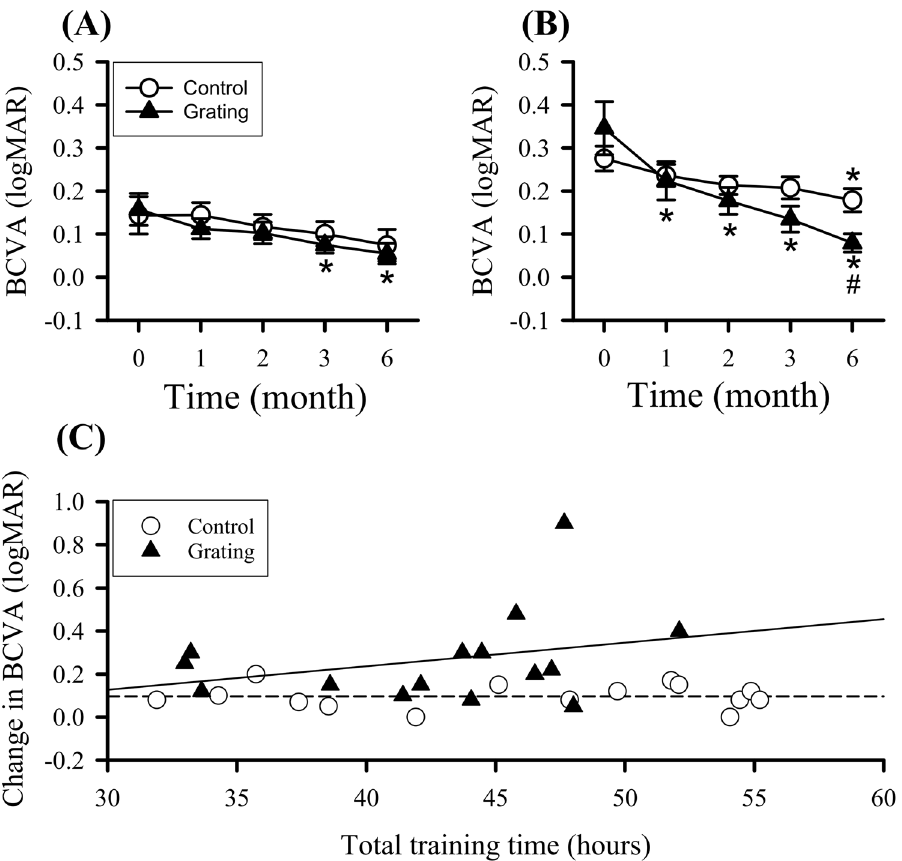
Figure 2. Best-corrected visual acuity (BCVA) at the baseline (0), 1st, 2nd, 3rd, and 6th months after the training. ( A ) BCVAs in patched eyes of the control and Grating groups. ( B ) BCVAs in trained eyes of the control and Grating groups. *p < 0.05 versus baseline, # p < 0.05 versus the control group. ( C ) Relationship between BCVA gain from the 6th month to baseline and total training time in trained eye of the two groups. The long dashed (control) and solid (Grating) lines represent the linear regression line fit the